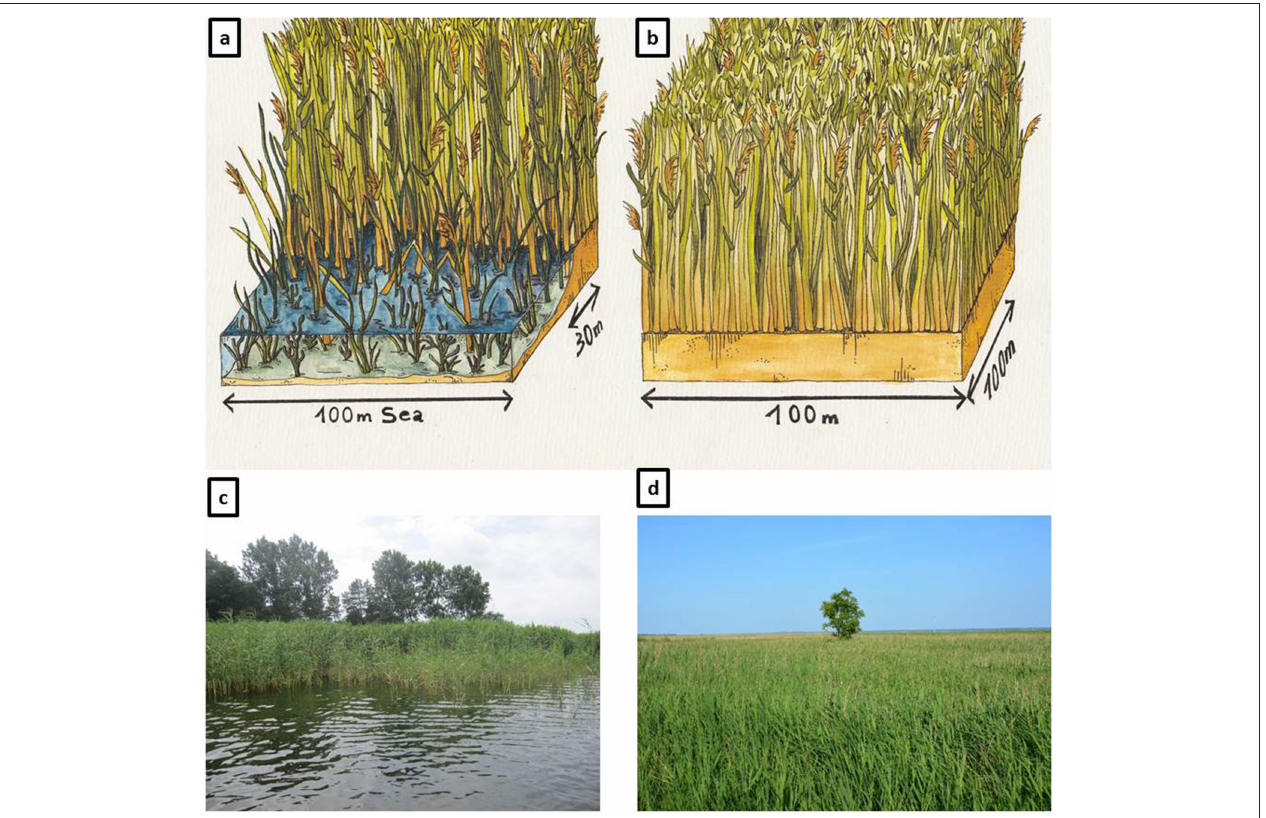
FIGURE 2 | Schematic representation and photos of transitional reed wetlands along coastlines (a,c) and homogeneous reed wetlands around shallow inland waters (b,d) . (Drawing by Ronja Trübger, with permission).